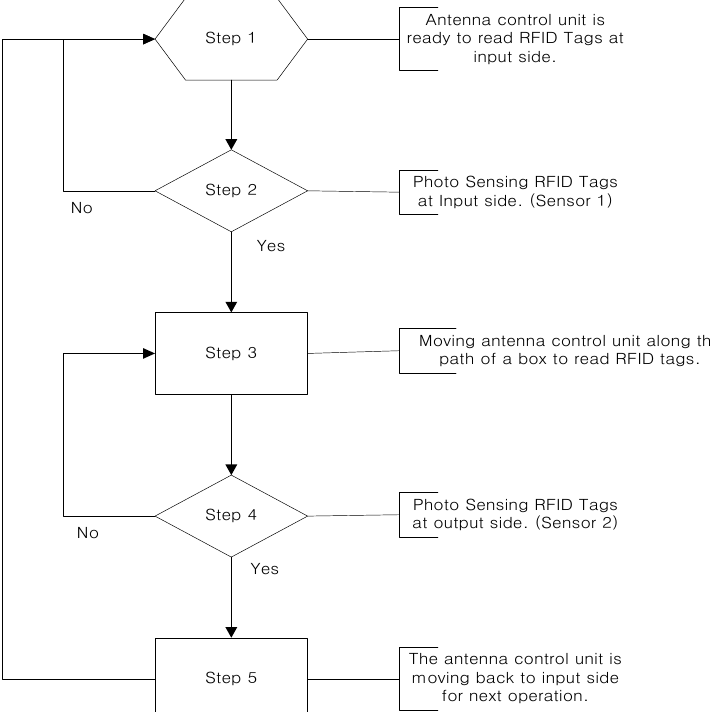
Figure 4. Operation flow of antenna control